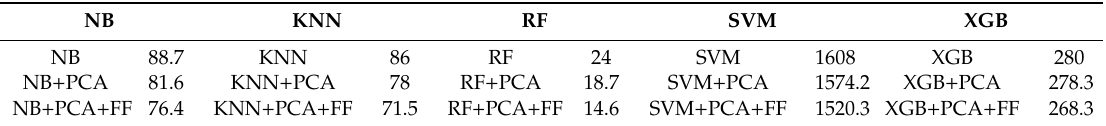
Table 1. Time taken for training the